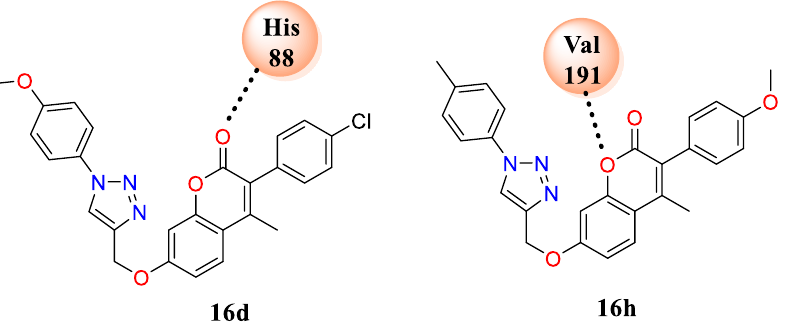
Figure 2. Docking images of compounds 16d and 16h showing H-bond interactions with 2VCX pro-